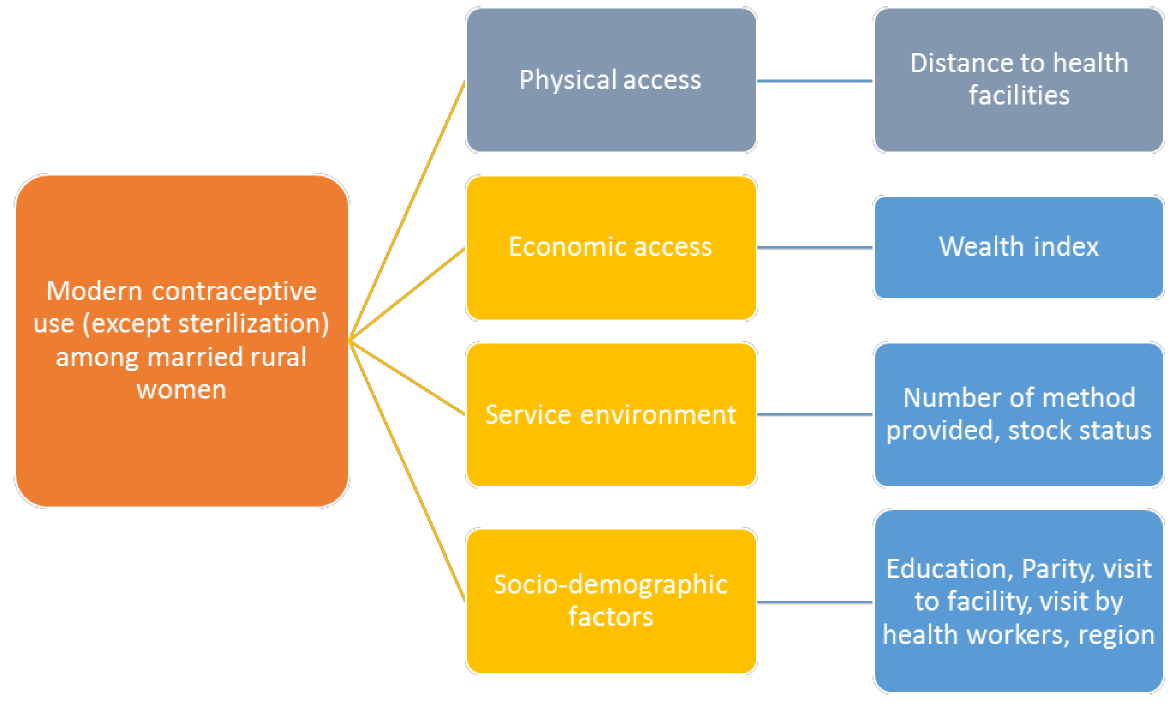
Fig 1. Conceptual frameworkfor